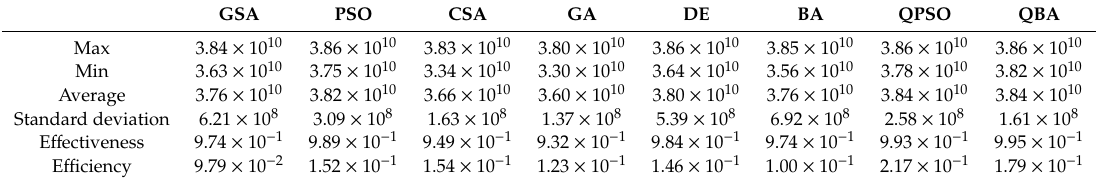
Table 5. Statistical data of applied metaheuristic algorithms on well placement optimization for case study